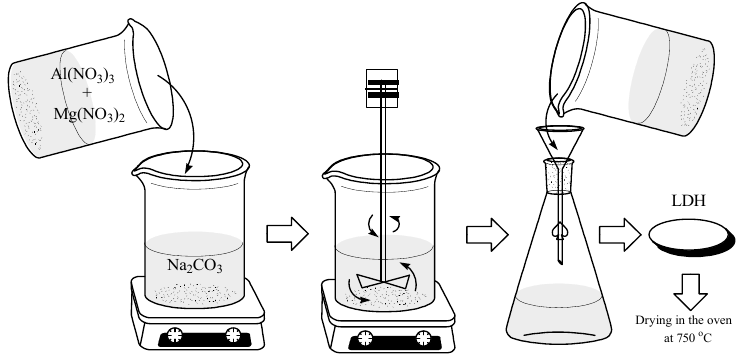
Figure 1. Schematic pathway to obtain layered double hydroxides (LDHs).